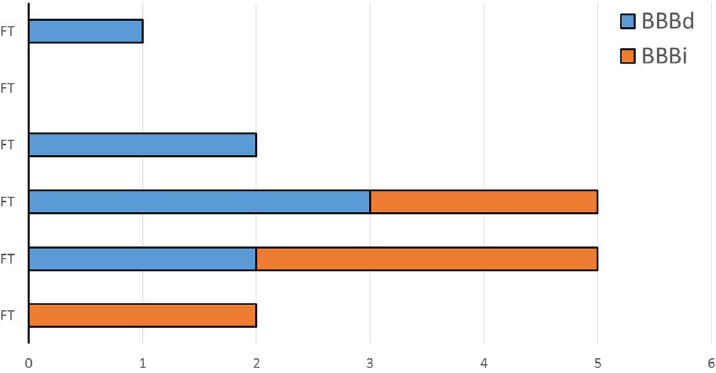
Fig 1. The y-axis shows the distribution in the number of the failed (i.e., performance > 1 SD below the respective reference mean) neuropsychological tests (min. 0, max. 5, FT = failed test, i.e. below average performance). The x- axis illustrates the number of patients according to this distribution. The CADP patients with an intact BBB (BBBi) are shown in orange and the patients with a BBB dysfunction (BBBd) are shown in blue.